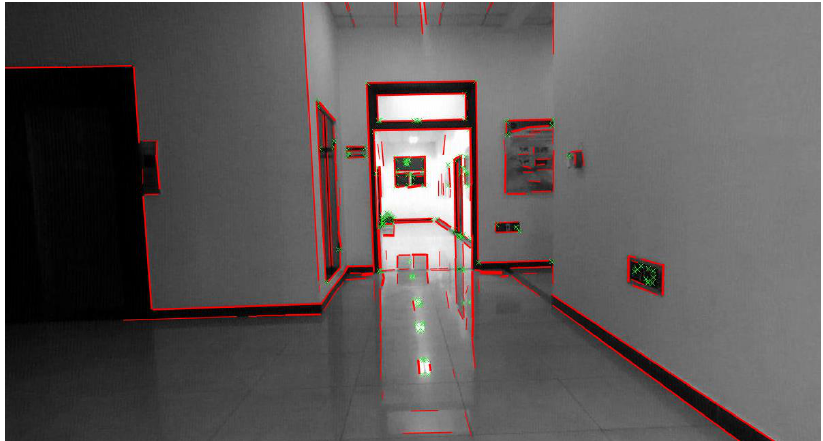
Figure 3. Common low-texture environment in an indoor scene with white walls, and point features (green x marks) extracted using ORB algorithm and line segment features (red lines) extracted using LSD